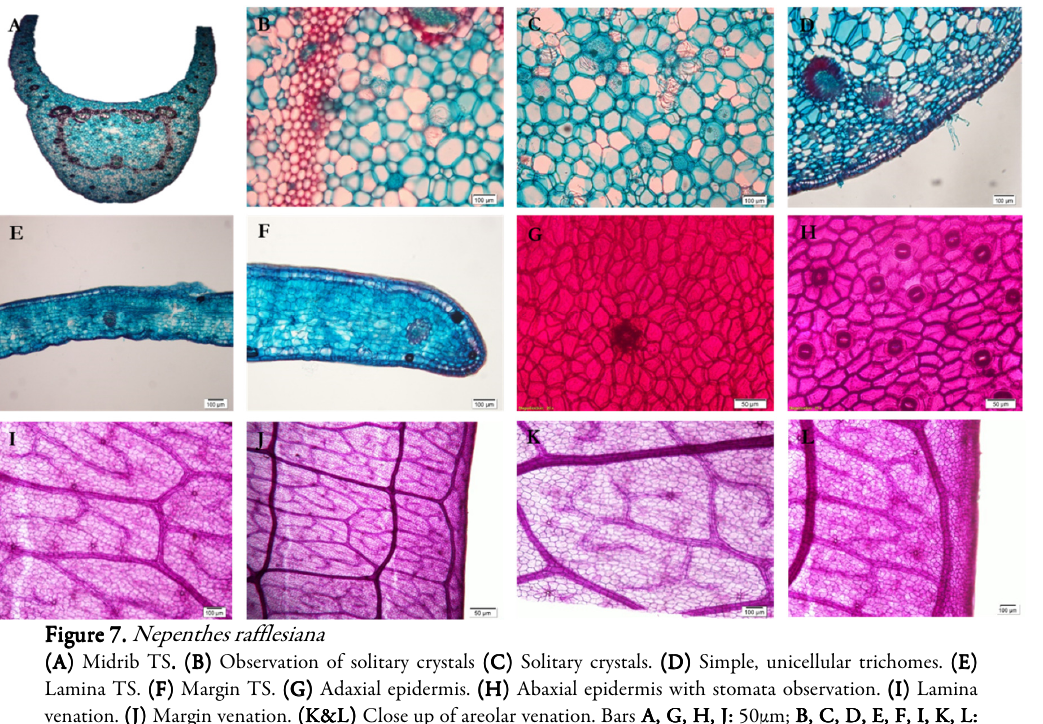
Figure 7. Nepenthes rafflesiana (A) Midrib TS. (B) Observation of solitary crystals (C) Solitary crystals. (D) Simple, unicellular trichomes. (E) Lamina TS. (F) Margin TS. (G) Adaxial epidermis. (H) Abaxial epidermis with stomata observation. (I) Lamina venation. (J) Margin venation. (K&L) Close up of areolar venation. Bars A, G, H, J: 50µm; B, C, D, E, F, I, K, L: